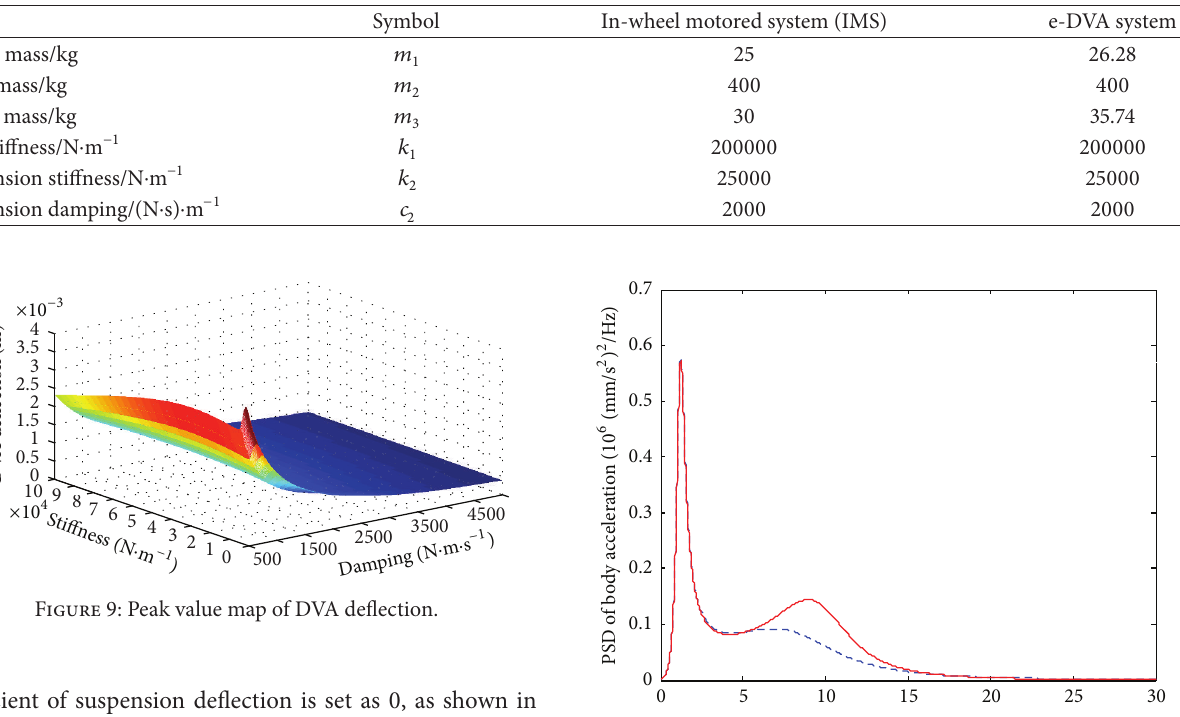
Table 2: Simulation parameters of 1/4 vehicle model.